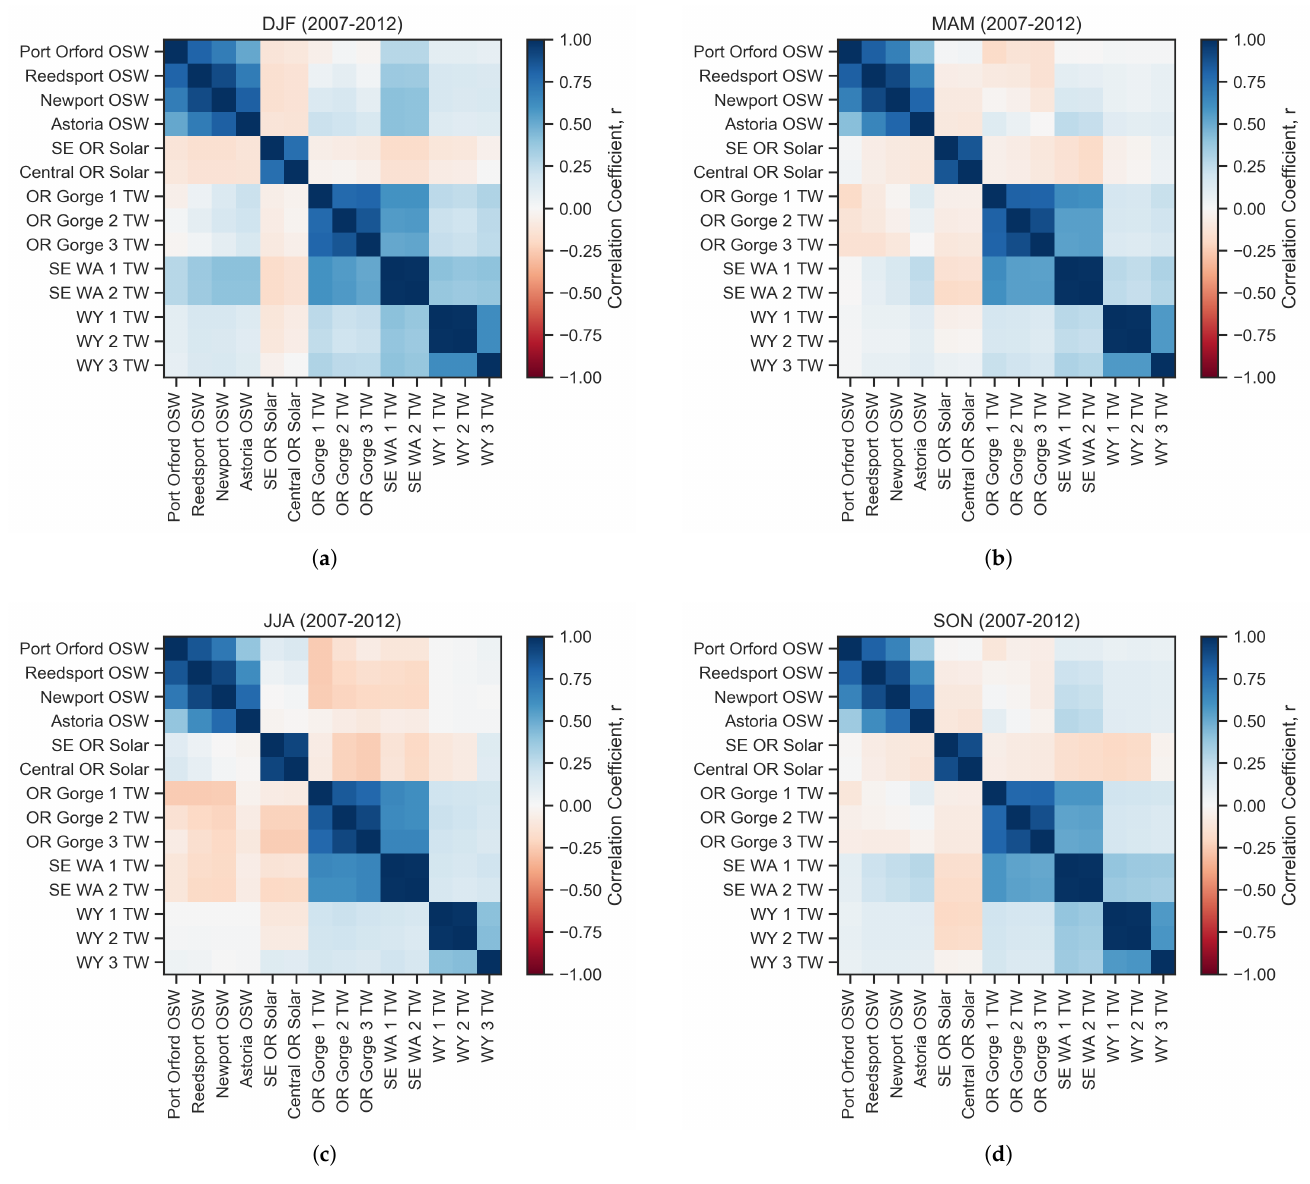
Figure 4. Seasonal resource complementarity 2007–2012: ( a ) December, January, February (DJF); ( b ) March, April, May (MAM); ( c ) June, July, August (JJA); ( d ) September, October, November (SON). Red colors indicate resource